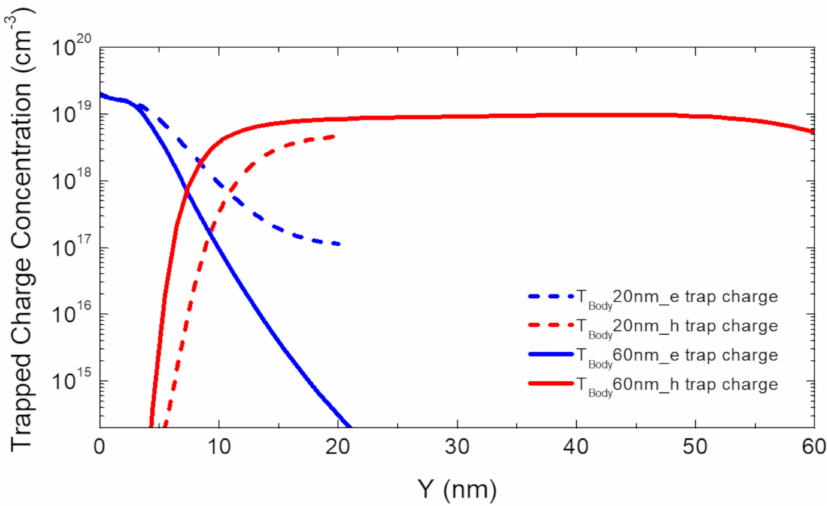
Figure 7. Trapped charge concentration in the Read”1” operation according to the GB position in a vertical cut when the Write”1” drain voltage is 1.0